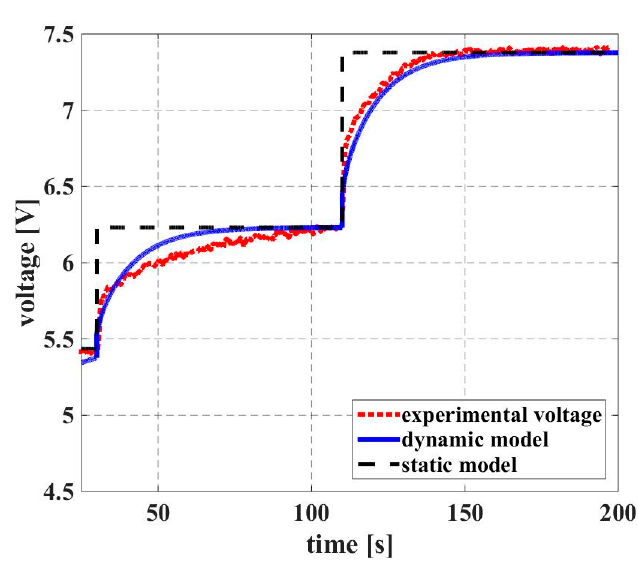
Figure 13. Comparison among the PEM EL voltage: experimental, obtained by dynamic model and by static model.